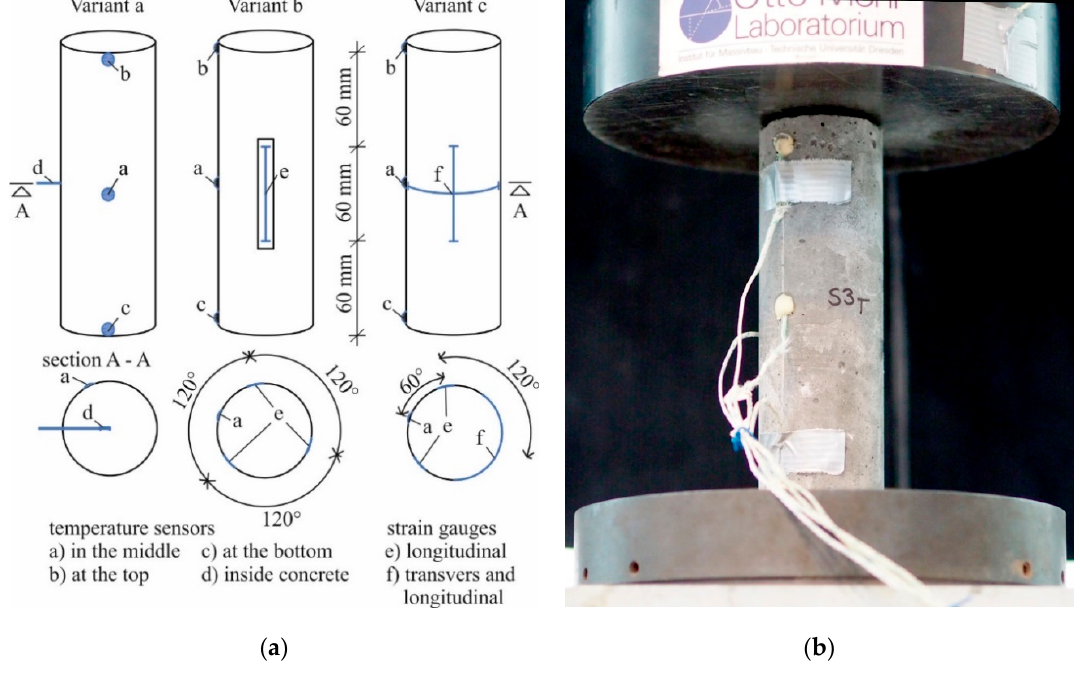
Figure 2. ( a ) Sample applications for fatigue tests; ( b ) Variant a in the testing machine.